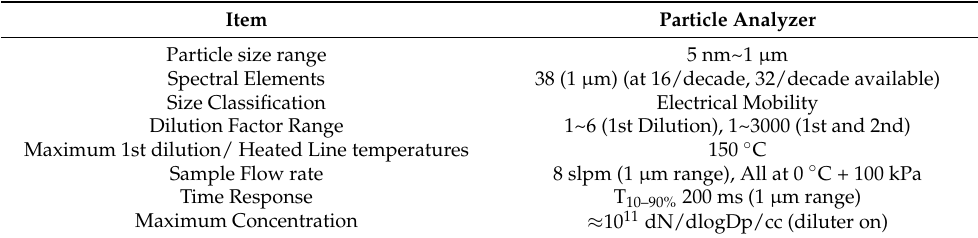
Figure 5. Vehicle operation setting on chassis dynamometer. Table 3. Specification of DMS-500 for measuring diesel particle number